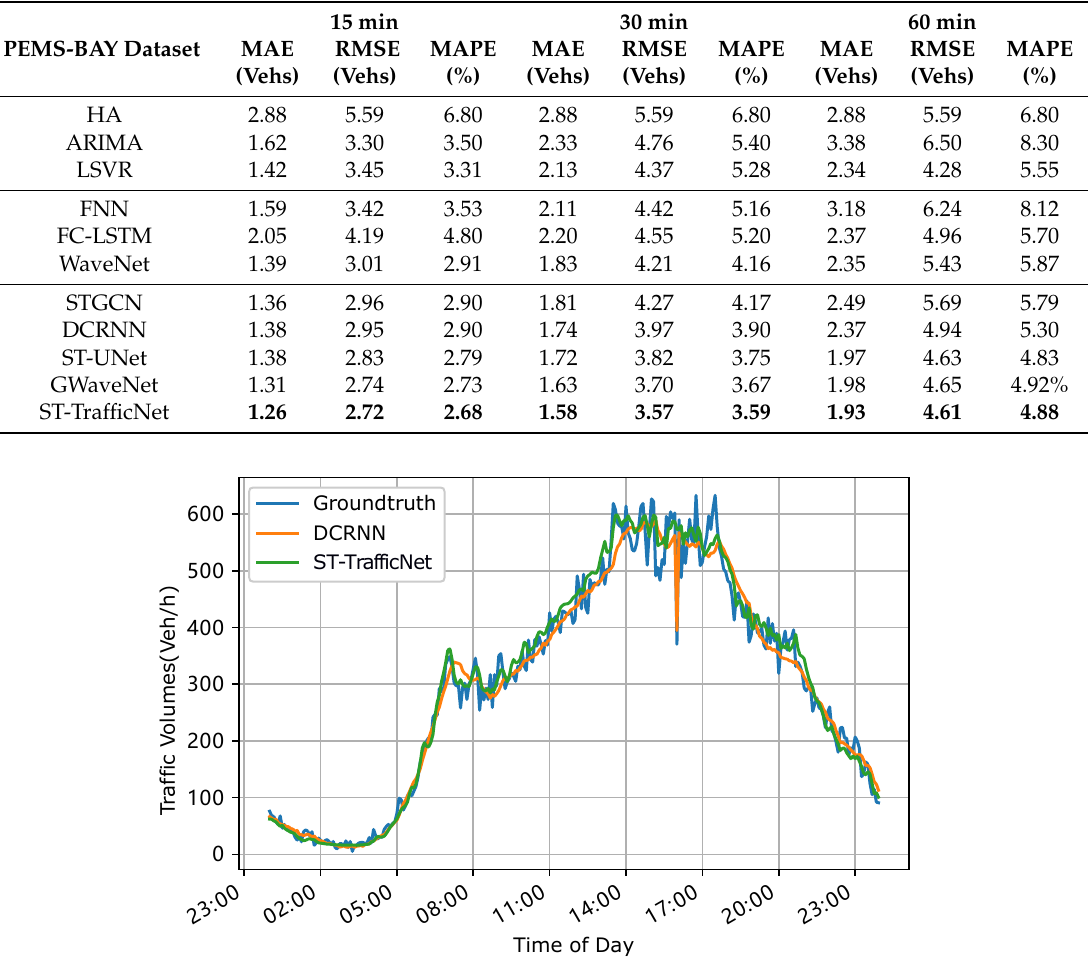
Figure 7. Comparison of Diffusion Convolutional Recurrent Neural Network (DCRNN), ST-TrafficNet, and ground truth in a day. The measurement point is selected from one of the most dense areas of PeMS-BAY. The curve of ST-TrafficNet is closer to ground truth and is able to avoid